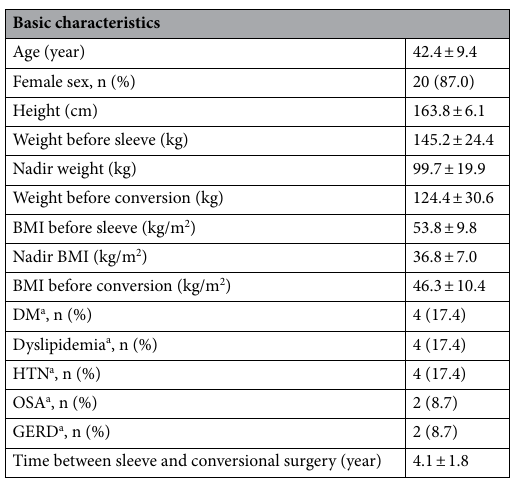
Table 1. Descriptive basic characteristics of patients (mean, SD, frequency and percent) (descriptive tests). DM diabetes mellitus, GERD gastroesophageal reflux disease, HTN hypertension, No number, OSA obstructive sleep apnea, SD standard deviation. a At the time of